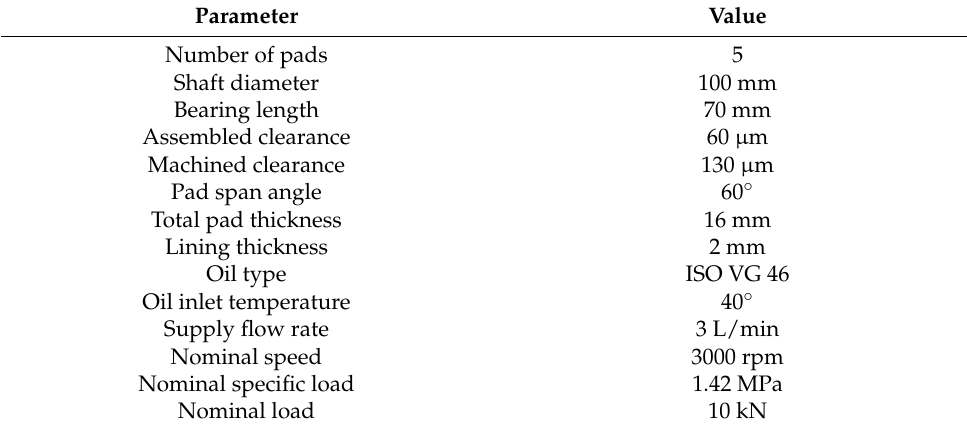
Table 1. Bearing geometry in nominal